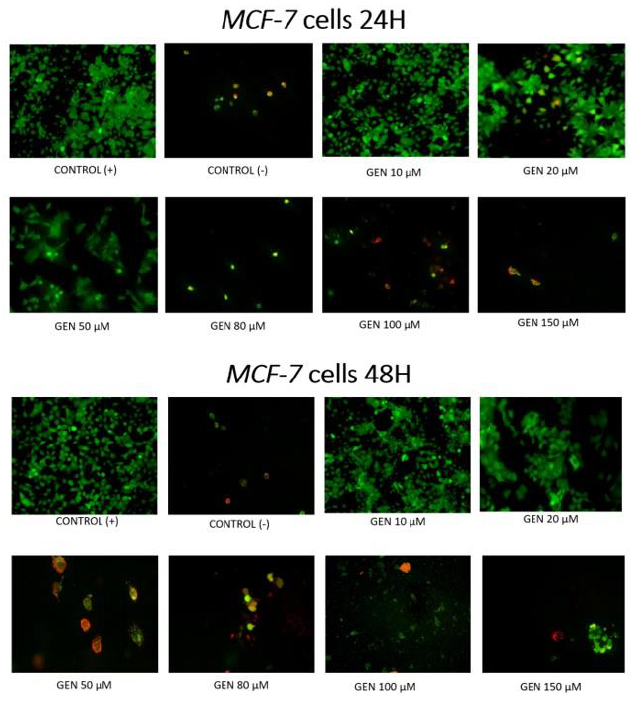
Figure 3. Induction of apoptosis by genistein at different concentrations in tumor MCF-7 cell lines in fluorescent microscope (magnification 400 × ). Cells were stained with annexin-Cy3.18 (AnnCy3) and 6-Carboxyfluorescein diacetate (6-CFDA). AnnCy3 binds to phosphatidylserine present in the outer leaflet of plasma membrane of cells starting the apoptotic process. The binding is observed as red fluorescence. 6-CFDA is used to measure viability. When this non-fluorescent compound enters living cells, esterases hydrolyze it, producing fluorescent compound 6-carboxyfluorescein (6-CF). This appears as green fluorescence. Cells cultured with 0.1% DMSO were considered as Control (+). Cells cultured with 15% DMSO were considered as Control ( −